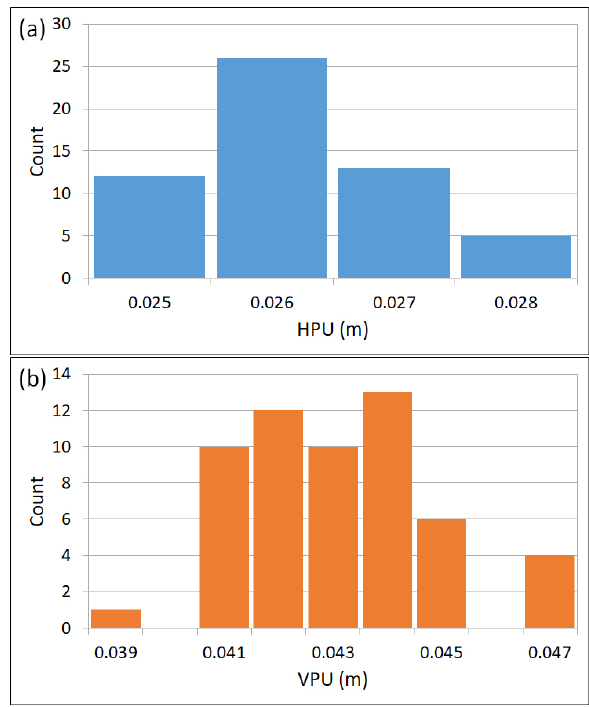
Fig. 8. Calculated (a) HPU and (b) VPU for NRTK observations based on the NRTK baseline network.